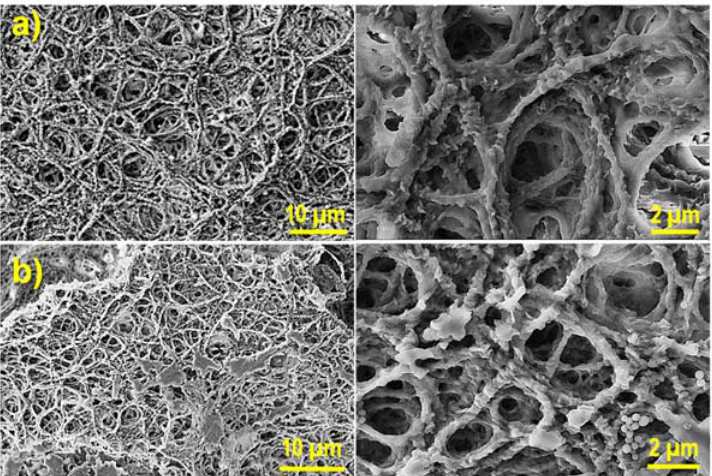
Figure 4. SEM micrographs (low and high magnifications) comparing the morphology of 100% crosslinked hydrogels derived from electrospinning solutions with polymer concentrations of 5 wt-% ( a ) and 8 wt-% ( b ).